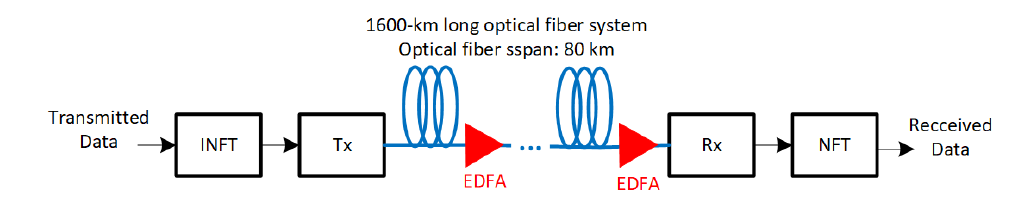
Figure 3. The schematic representation of an NFDM optical fiber transmission system.